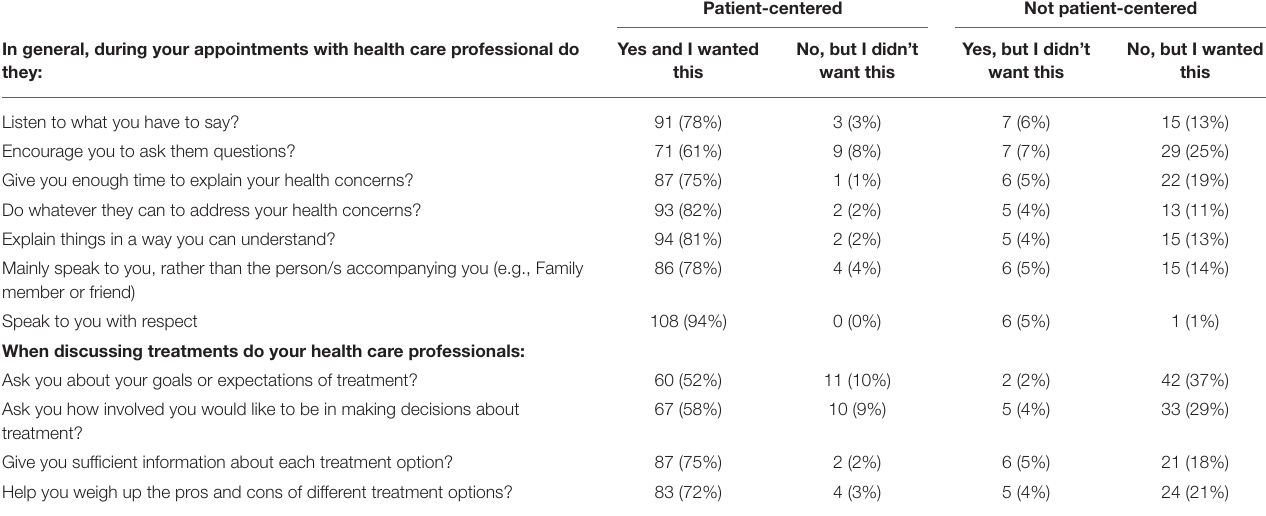
Patient-centered Not